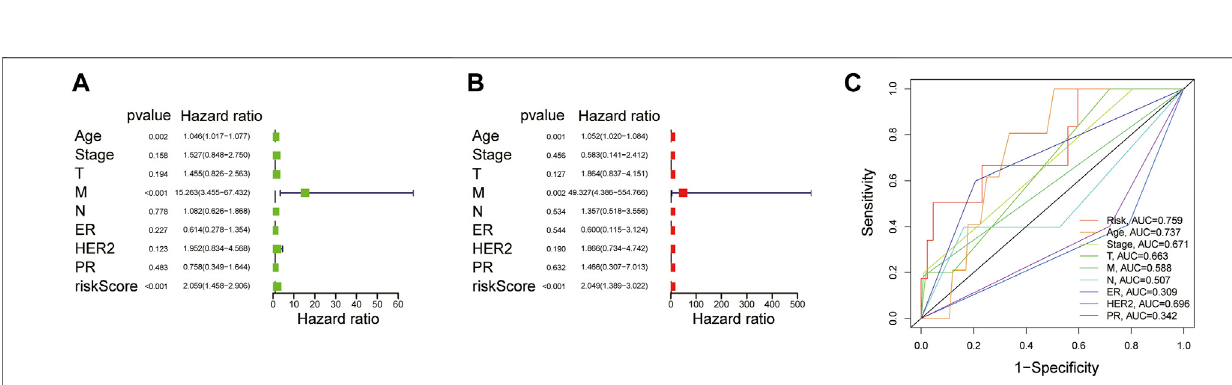
drug sensitivity. The three-dimensional structures of drugs were obtained through the PubChem database (https://pubchem.ncbi.